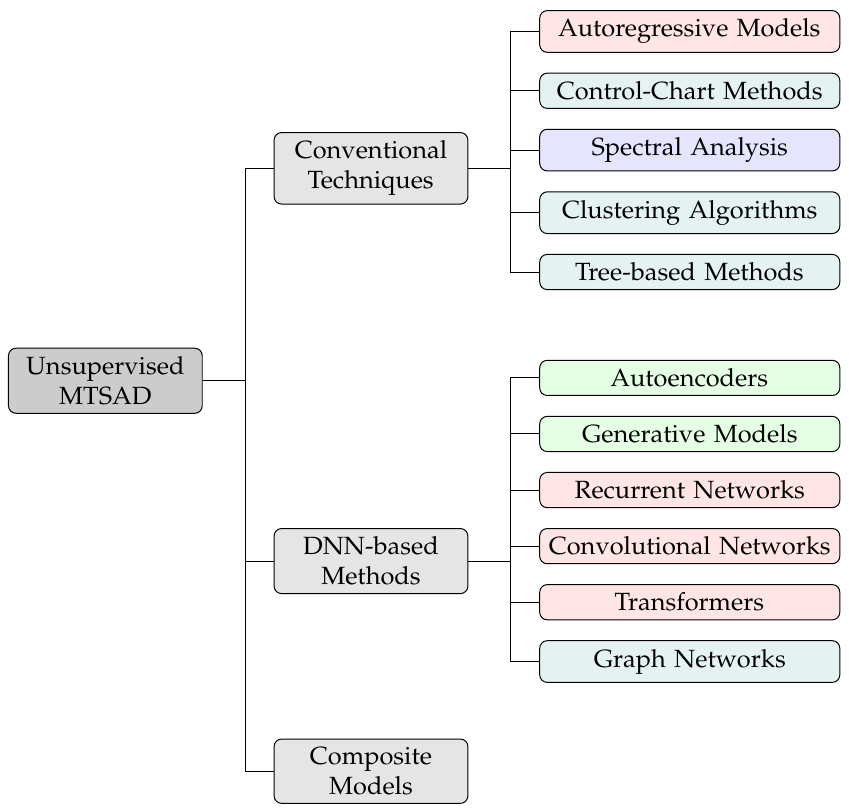
Figure 3. Unsupervised MTSAD methods. The colors red, green and blue indicate approach type as in Figure 2. Teal indicates that both compression and reconstruction approaches can be